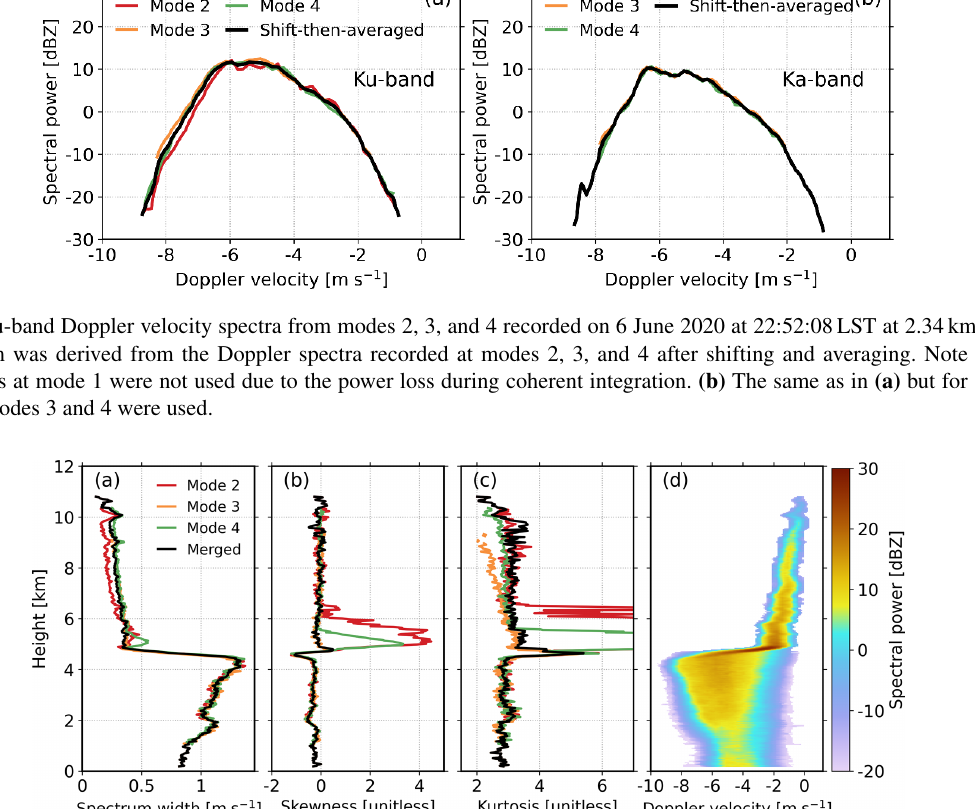
Figure 12. (a) Spectrum width, (b) skewness, and (c) kurtosis estimated from Ku-band radar Doppler spectra recorded at modes 2, 3, and 4, as well as the merged data; (d) the profile of merged Doppler velocity spectra. Note that Ku-band radar observations at mode 1 were not used due to the power loss during coherent